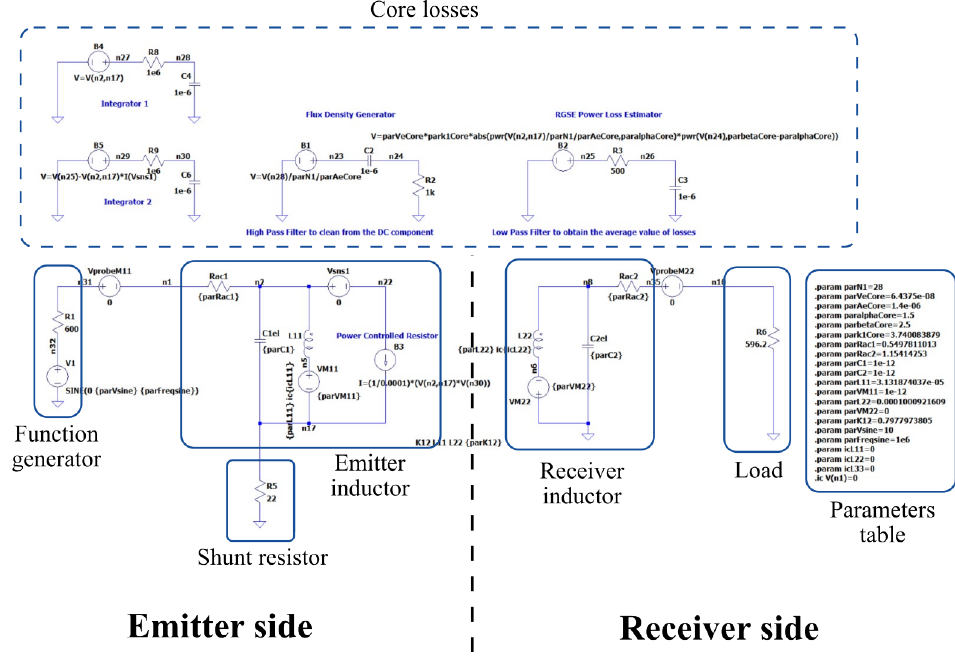
Figure 6. Equivalent circuit model for the time domain analysis.